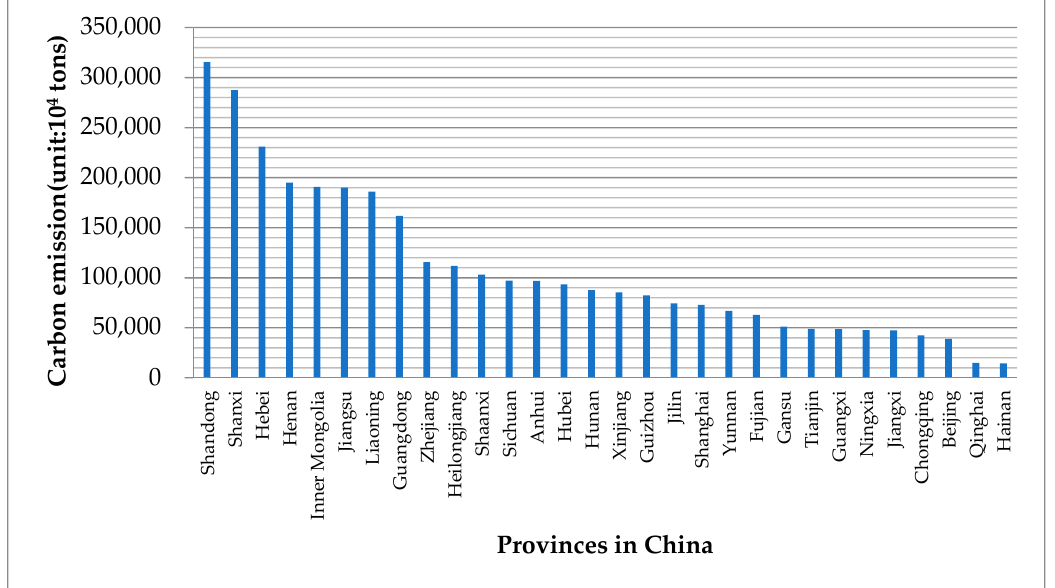
Figure 4. Accumulative carbon emissions from 2004 to 2014 for 30 provinces (districts) in China.